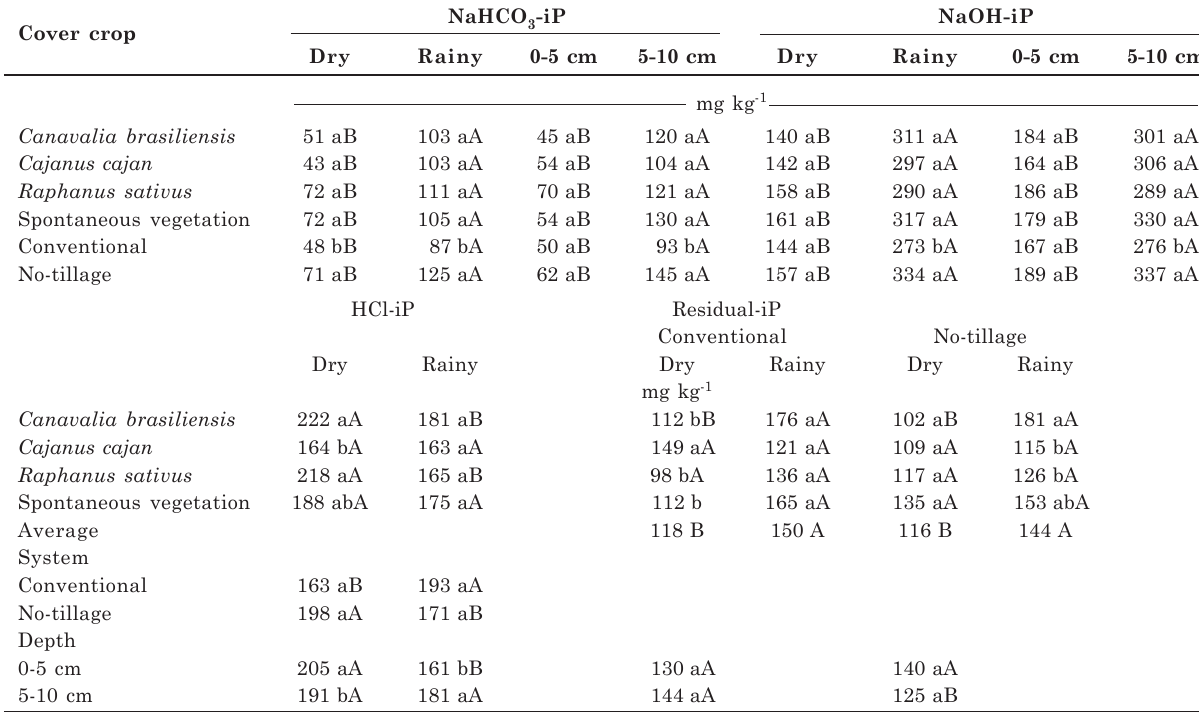
Table 2. Concentrations of the inorganic phosphorus fractions and of residual phosphorus in a soil with a cover crop under conventional and no-tillage systems at two depths and two seasons (dry and rainy)